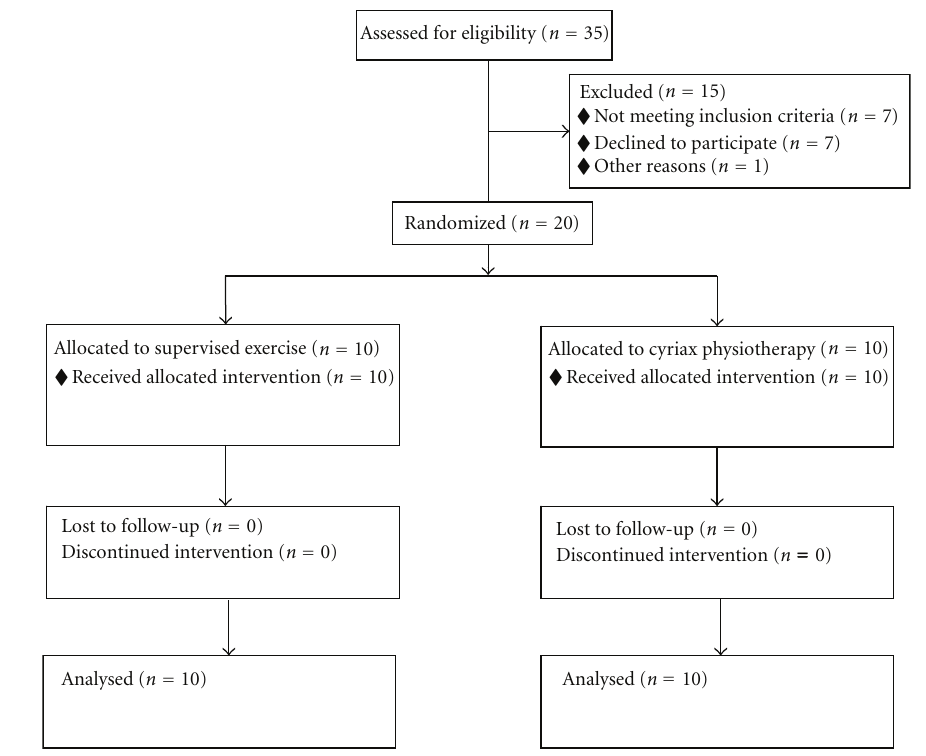
Figure 3: Participants flow chart. Table 1: Mean, standard deviation (SD), & standard error (SE) of age.